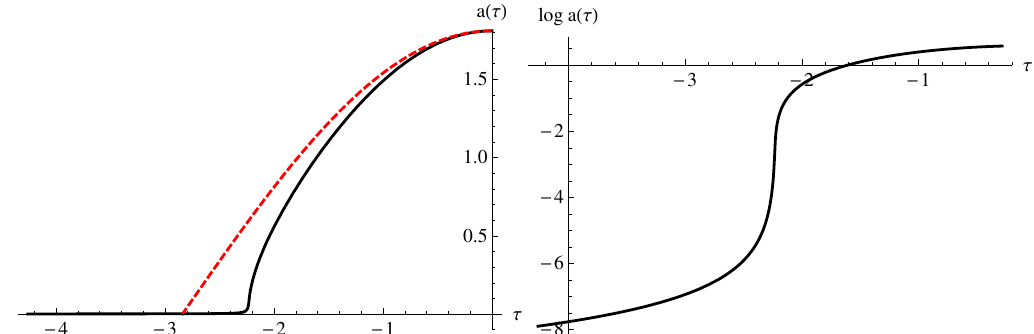
Figure 4. The black curve is an example of ˙ a 2 for Λ = 1, G = 1, and l Pl = 0.1, where the red dashed curve is the limit of the Einstein gravity with the same a max that satisfies ˙ a max = 0. Right is the behavior near the a = 0 limit.